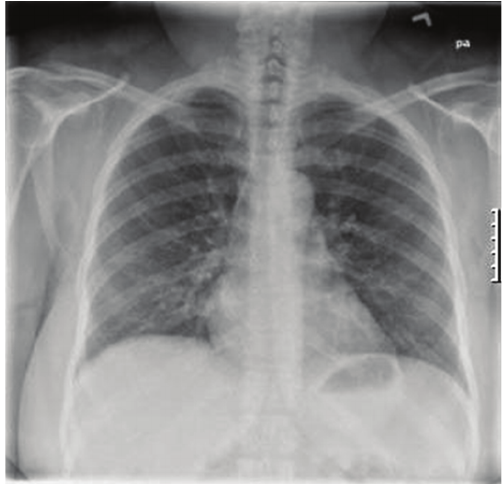
Figure 2: Chest radiograph on day no. 3, a near normal study with marked radiological resolution of interstitial